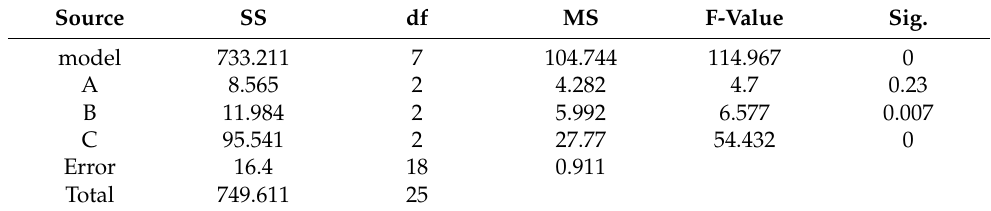
Table 2. Results of variance analysis of orthogonal experiment for pressure, time and